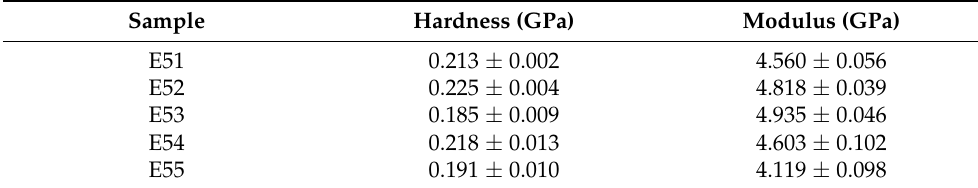
Table 4. Hardness and modulus values of the ZnO-modified epoxy